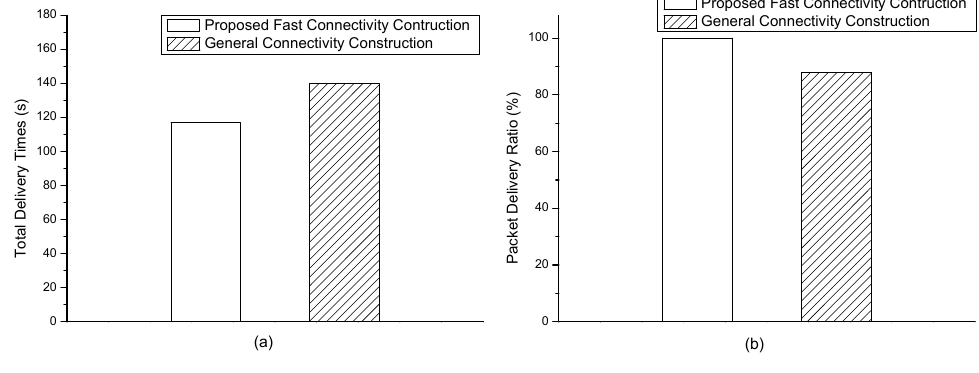
Figure 5. ( a ) Total Delivery times. ( b ) Packet Delivery Ratio.